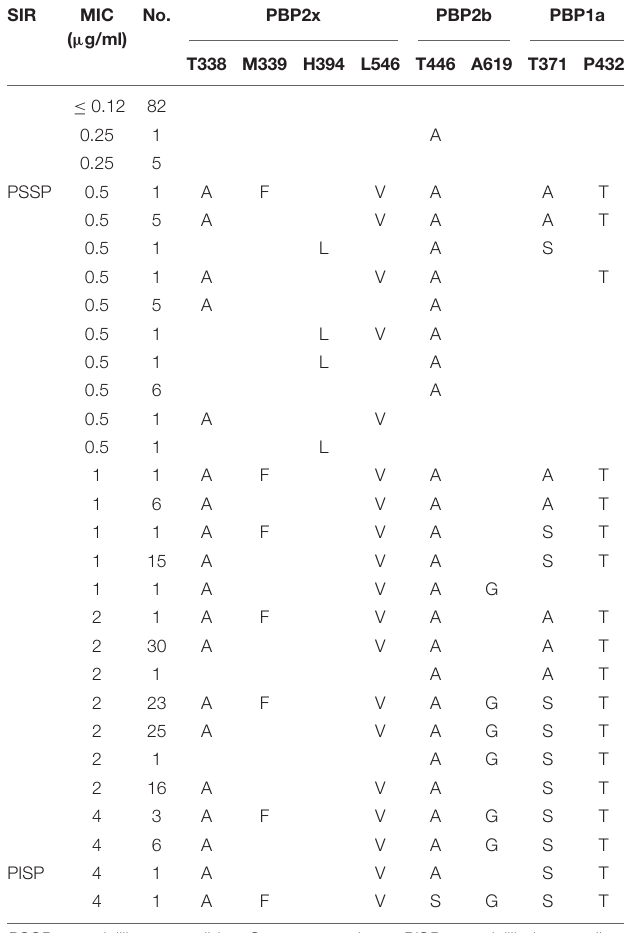
TABLE 6 | Association of penicillin susceptibility and variations of conserved motifs forming or surrounding active penicillin-binding proteins (PBPs) binding sites in PBP2x, PBP2b, PBP1a in S. pneumoniae isolates from non-CSF specimens.